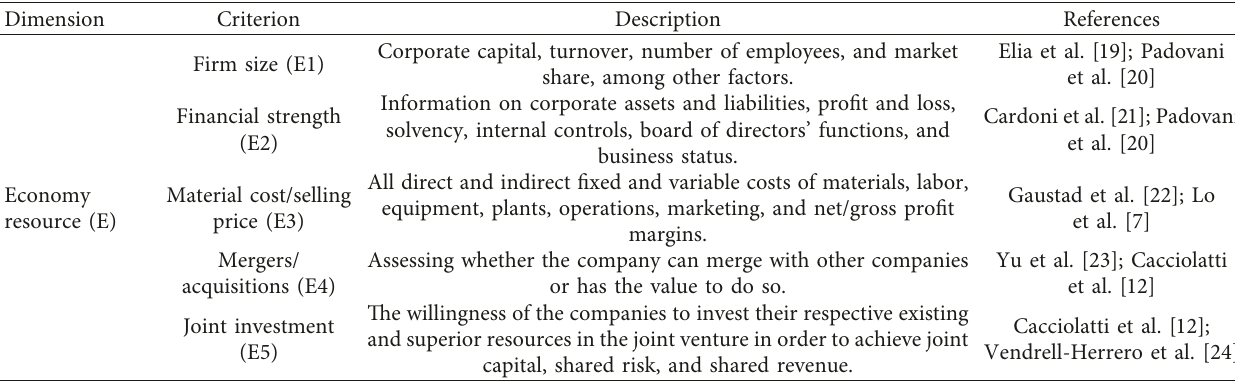
Table 1: The economy resource dimension and its criteria.